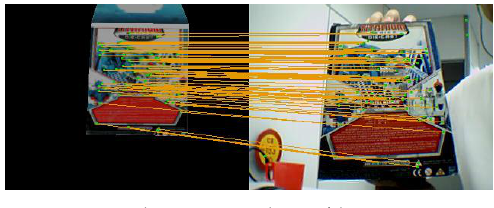
Figure 13. Keypoint